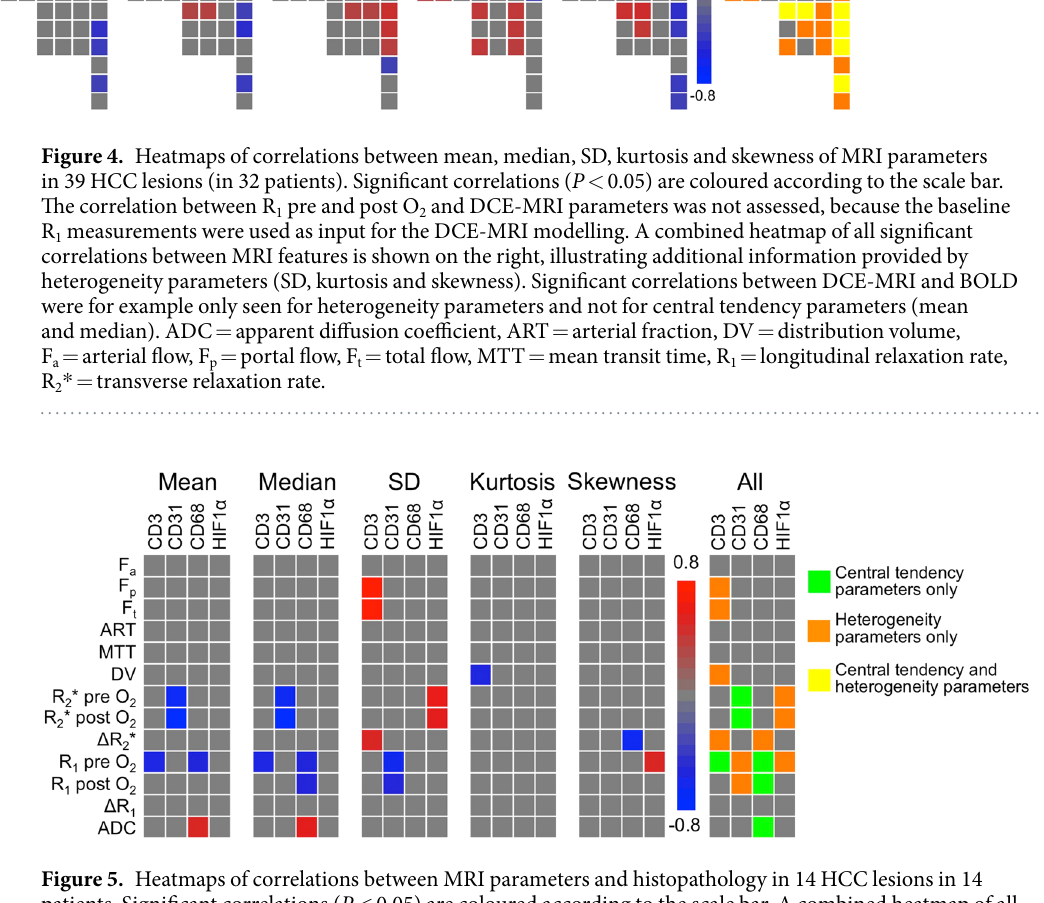
Figure 5. Heatmaps of correlations between MRI parameters and histopathology in 14 HCC lesions in 14 patients. Significant correlations ( P < 0.05) are coloured according to the scale bar. A combined heatmap of all significant correlations between MRI features and histopathology is shown on the right, illustrating additional information provided by heterogeneity parameters (SD, kurtosis and skewness). For example, HIF1 α tumour fractions correlated with heterogeneity parameters, but not with central tendency parameters (mean and median). ADC = apparent diffusion coefficient, ART = arterial fraction, CD3 = cluster of differentiation 3, CD31 = cluster of differentiation 31, CD68 = cluster of differentiation 68, DV = distribution volume, F a = arterial flow, F p = portal flow, F t = total flow, HIF1 α = hypoxia-inducible factor 1-alpha, MTT = mean transit time, R 1 = longitudinal relaxation rate, R 2 * = transverse relaxation